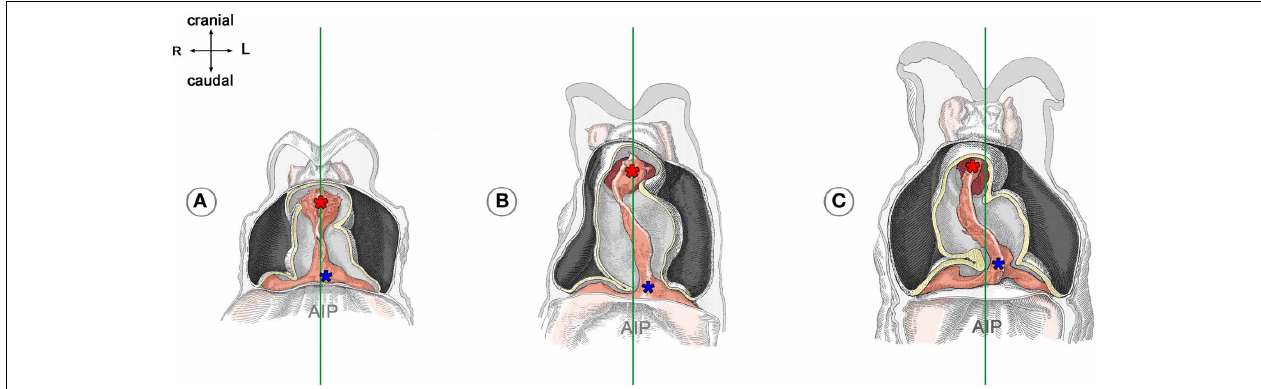
FIGURE 3 | These drawings depict the asymmetric positioning of the venous pole of human embryonic heart tubes before the onset (A) and during the initial steps of cardiac looping (B,C). Hearts are shown in frontal views within the opened pericardial cavities. The ventral myocardial walls have been removed to facilitate views on the endocardial tubes. (A) Before the onset of looping, the center axis of the